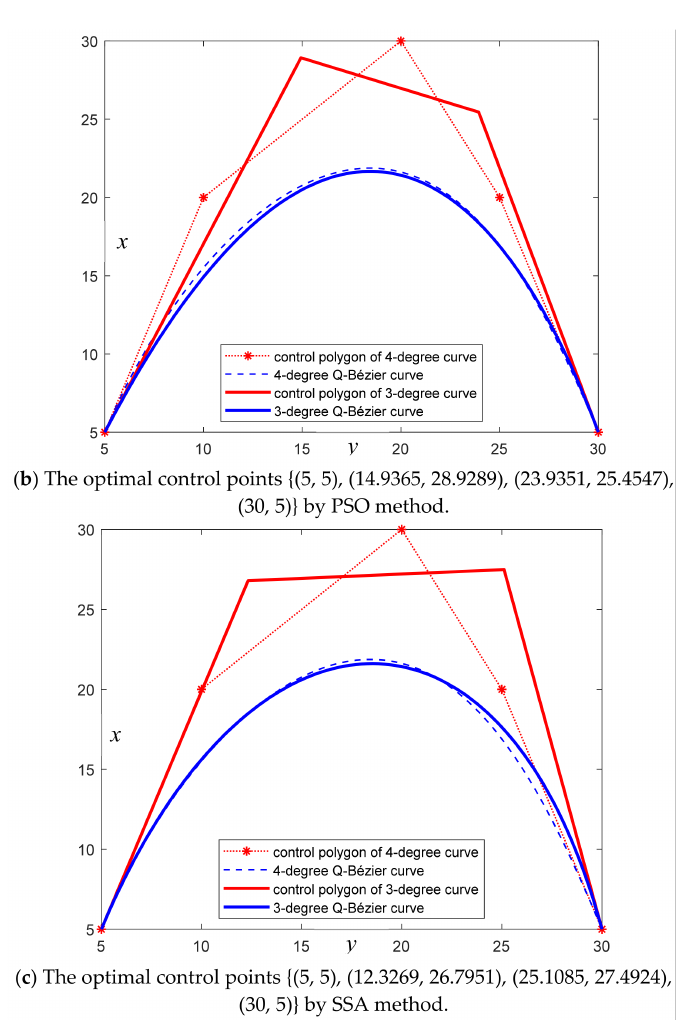
Figure 8. Comparisons of one-degree reduction among GA method, PSO method and SSA method; under C 0 constraint condition.